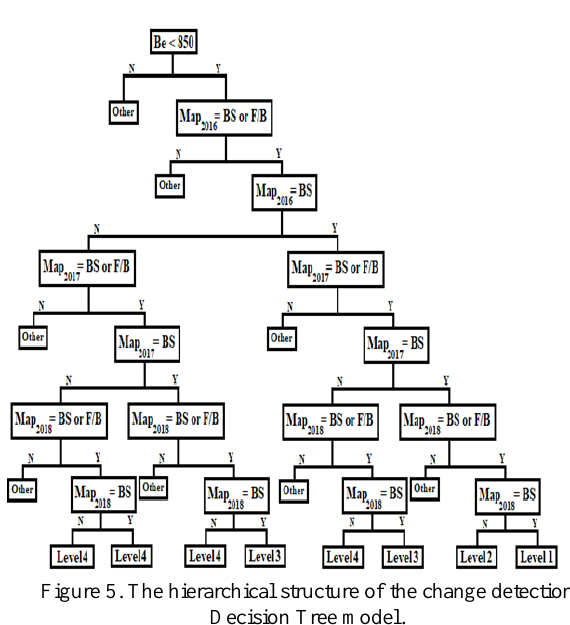
Figure 5. The hierarchical structure of the change detection Decision Tree model.